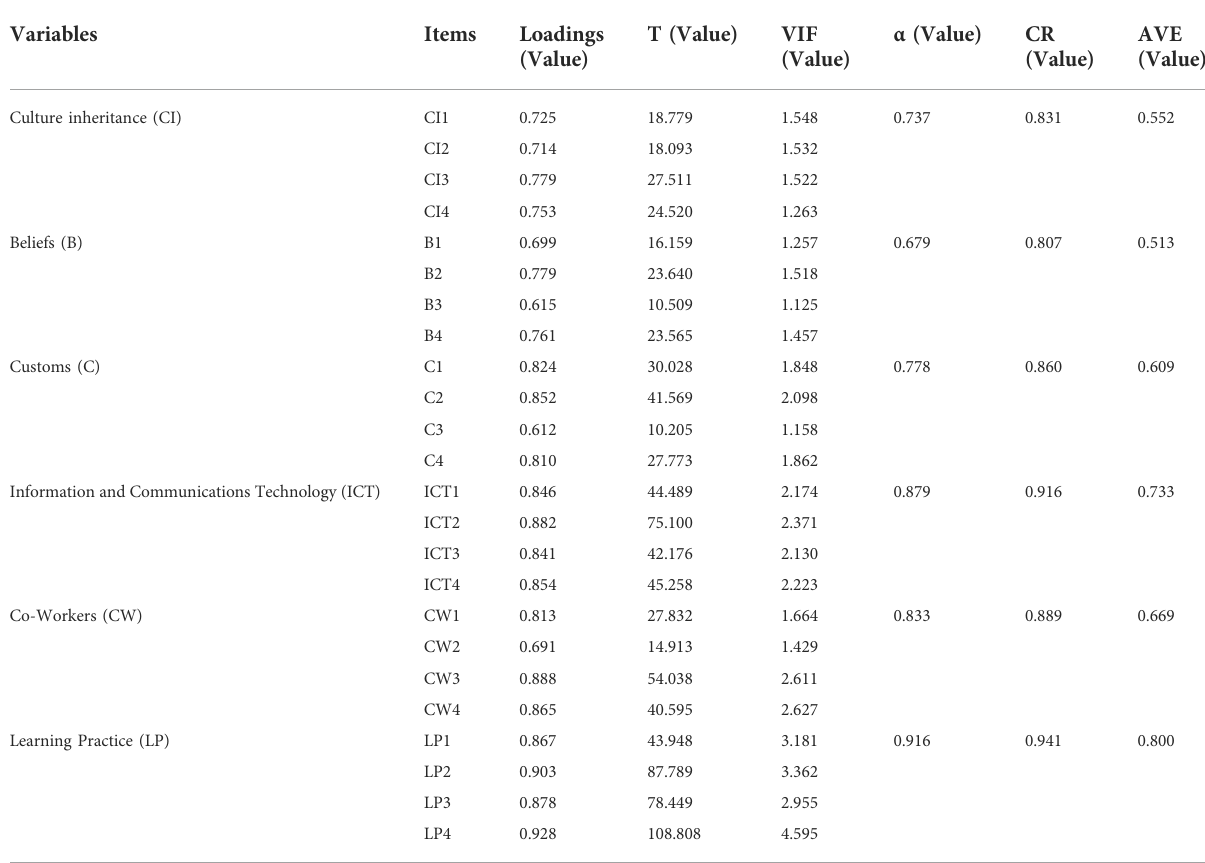
TABLE 2 Reliability and validity analysis.